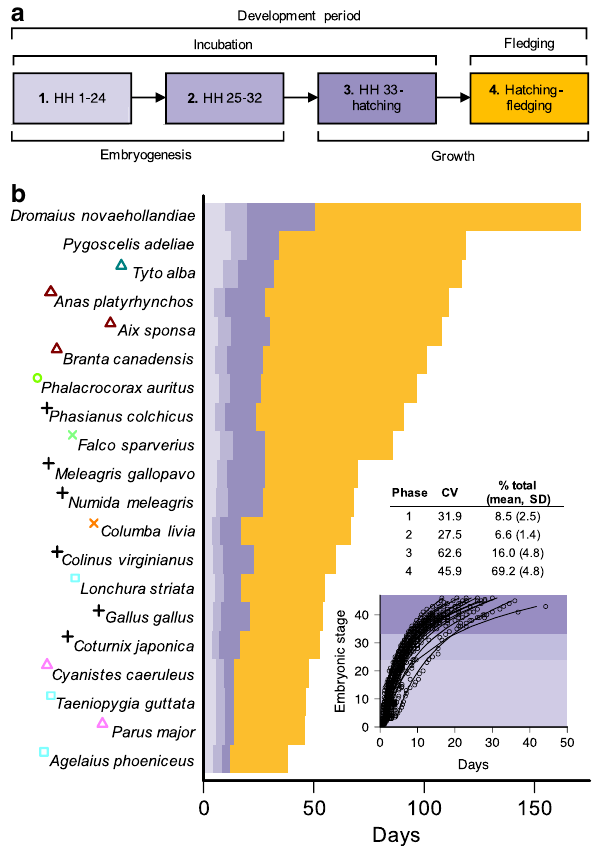
Fig. 1 The duration of avian developmental phases. a Schematic illustrating four distinct phases of avian ontogeny. Phase 1 and phase 2 corresponding to Hamburger – Hamilton stages (HH) 1 – 24 and 25 – 32, respectively, represent embryonic developmental stages primarily associated with embryogenesis (i.e., non-growth). In contrast, phases 3 (HH33 to hatching) and 4 (post-hatching fl edging period) correspond to developmental periods consisting largely of growth. b Stacked bar chart showing time intervals associated with phases 1 to 4 for 20 bird species with available information on the timing of embryonic developmental stages, with species are ordered by total developmental duration. Coloured symbols next to species names correspond to the major taxonomic groups identi fi ed in Fig. 2. Inset graph shows the staging data and fi tted curves used to estimate the time points separating phases 1 – 3. Inset table reports the coef fi cient of variation (CV) and percentage of total developmental period length (% total) accounted for by each of the four phases. Source data are provided as a Source Data fi